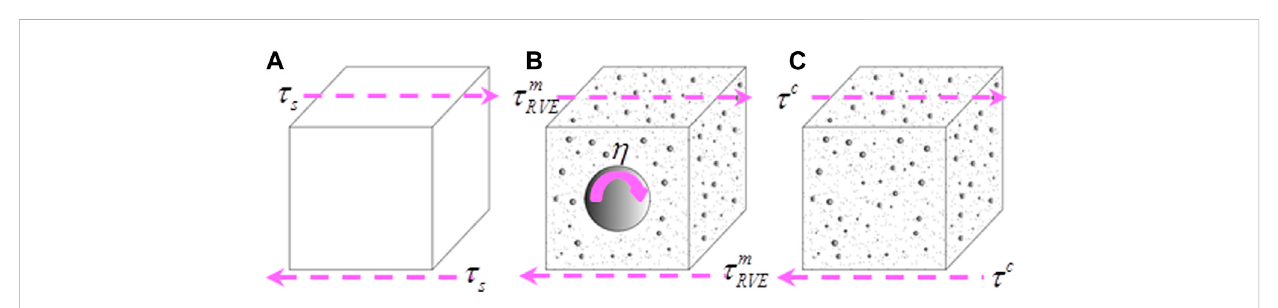
FIGURE 3 The stress state of the soil-rock mixture, RVE and the pure soil matrix. (A) soil-rock cell; (B) , RVE ingredients; (C) pure soil matrix.